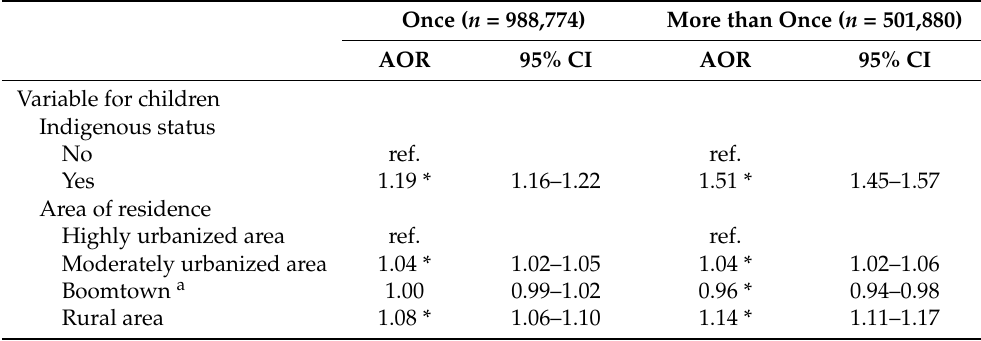
Table 3. Results of logistic regression of risk factors for children who had ER/clinic visit or hospital admission (once vs. more than once). Once ( n = 988,774) More than Once ( n = 501,880) AOR 95% CI AOR Variable for children